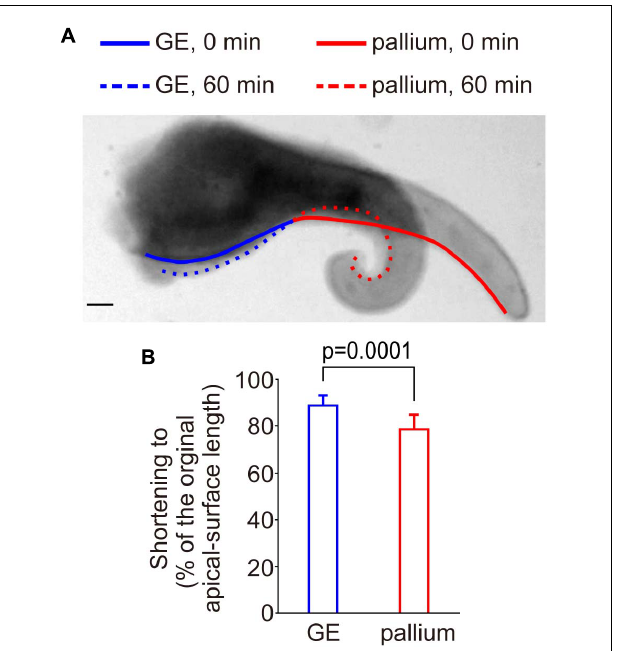
FIGURE 7 | Spontaneous narrowing/shortening of the apical surface of sliced E12 cerebral walls. (A) An example of bending/curling of the pallium (i.e., shortening of the apical surface, red) accompanied with narrowing of the apical surface of GE (blue). Scale bar, 100 µ m. (B) Graph comparing the shortening of the apical surface (from 0 to 60 min) between the pallium and the GE. The apical surface of the pallium ( n = 6 slices) more significantly shortened than that of the GE ( n = 6 slices) ( p = 0.0001, Mann–Whitney U -test). convex (GE) and concave (pallial) cerebral wall apical